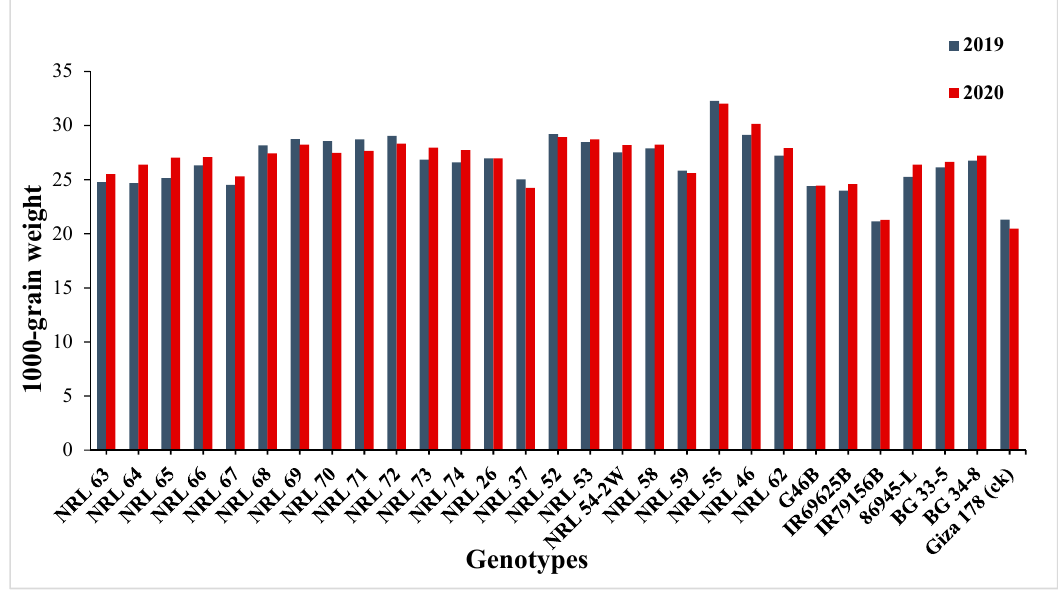
Figure 2. Mean performances for 1000 grain weight (g) of the studied genotypes during 2019 and 2020 growing